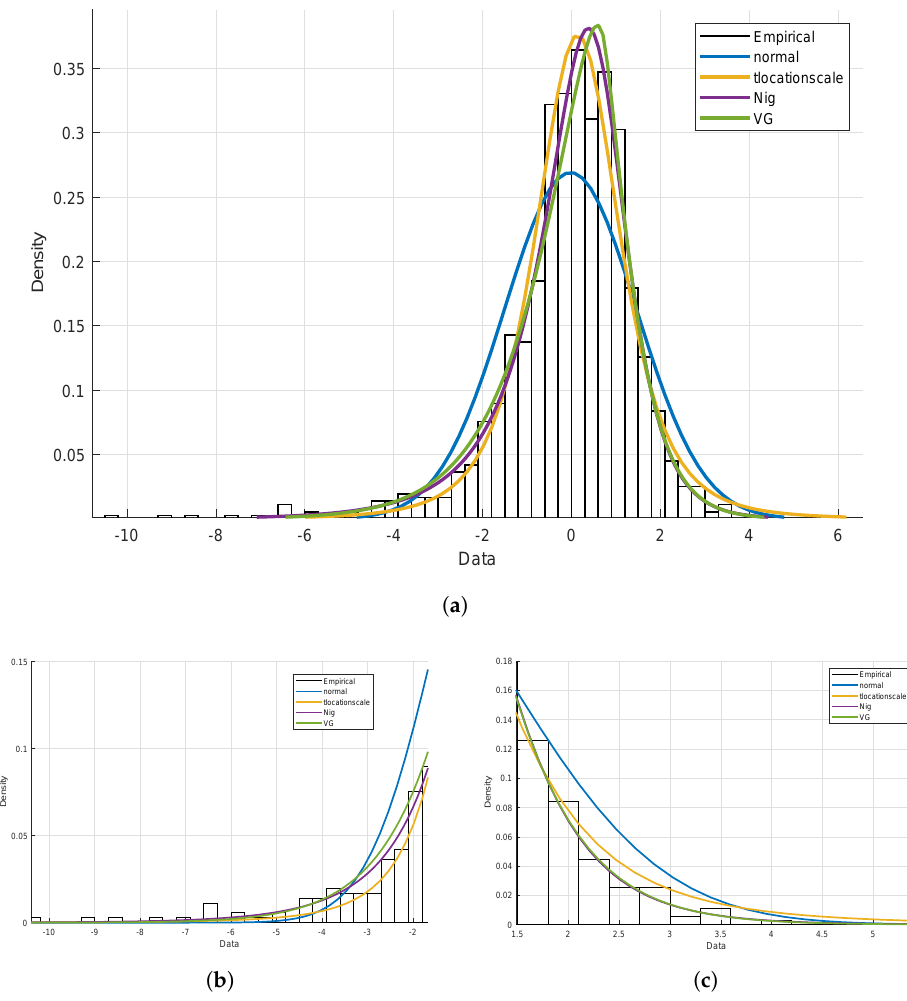
(cid:16) (cid:17) Y , panel ( a – c ), and its tails, panels ( b , c ) . C